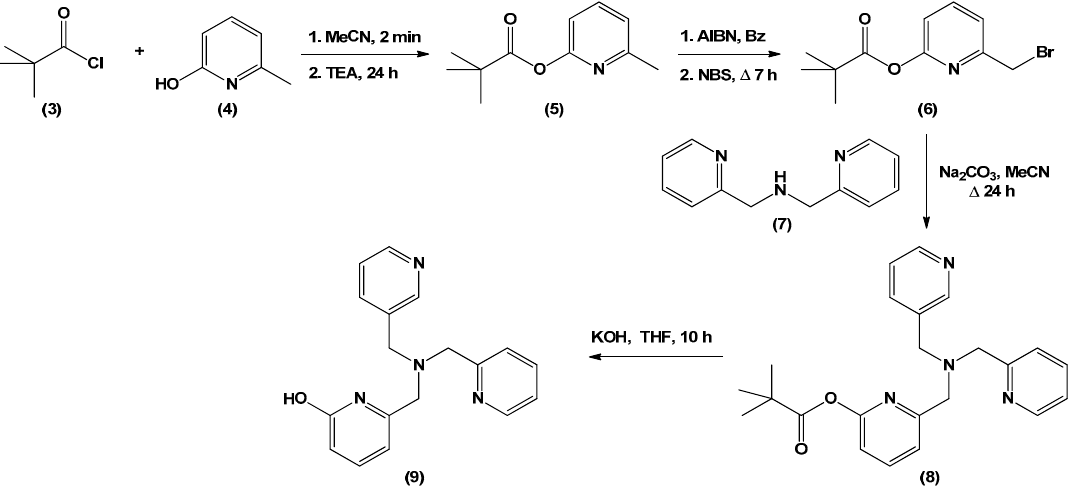
Figure 3. Synthesis of 6-(((pyridin-2-ylmethyl)(pyridin-3-ylmethyl)amino)methyl)pyridin-2-ol ( 9 ). [(TPA-OH)Zn(OH 2 )](ClO 4 ) 2 (2)